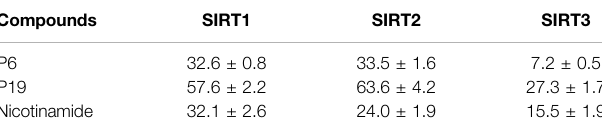
TABLE 2 | Enzyme inhibitory selectivity of representative compounds (IC 50 , µM a ).